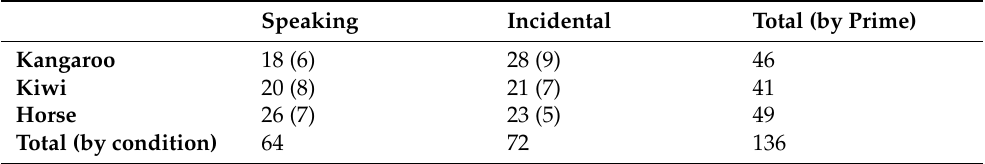
Table 6. Distribution of participants across conditions. Number of men indicated in